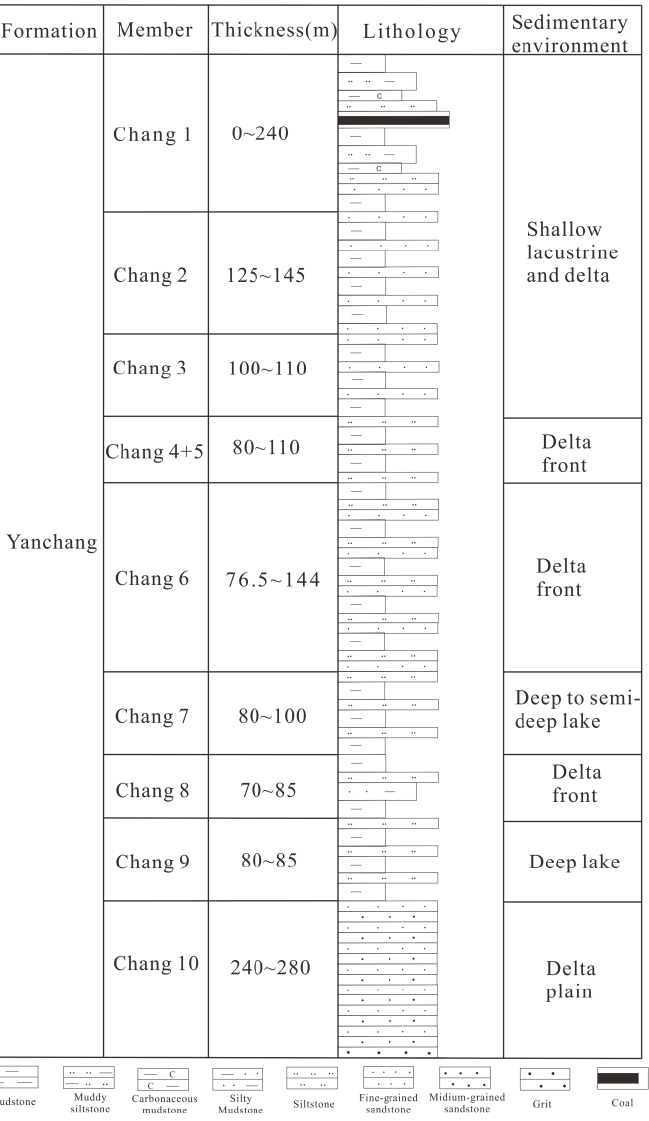
Figure 2. Stratigraphic column of the Yanchang Formation in the southwestern Ordos Basin.